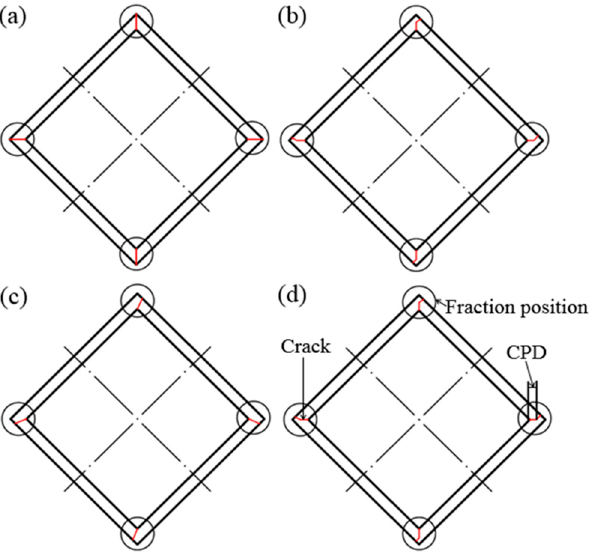
Figure 15. Schematic diagram of fracture model of expansion test: ( a ) Type I; ( b ) Type II; ( c ) Type III; ( d ) Crack propagation distance (CPD) along the weld line.